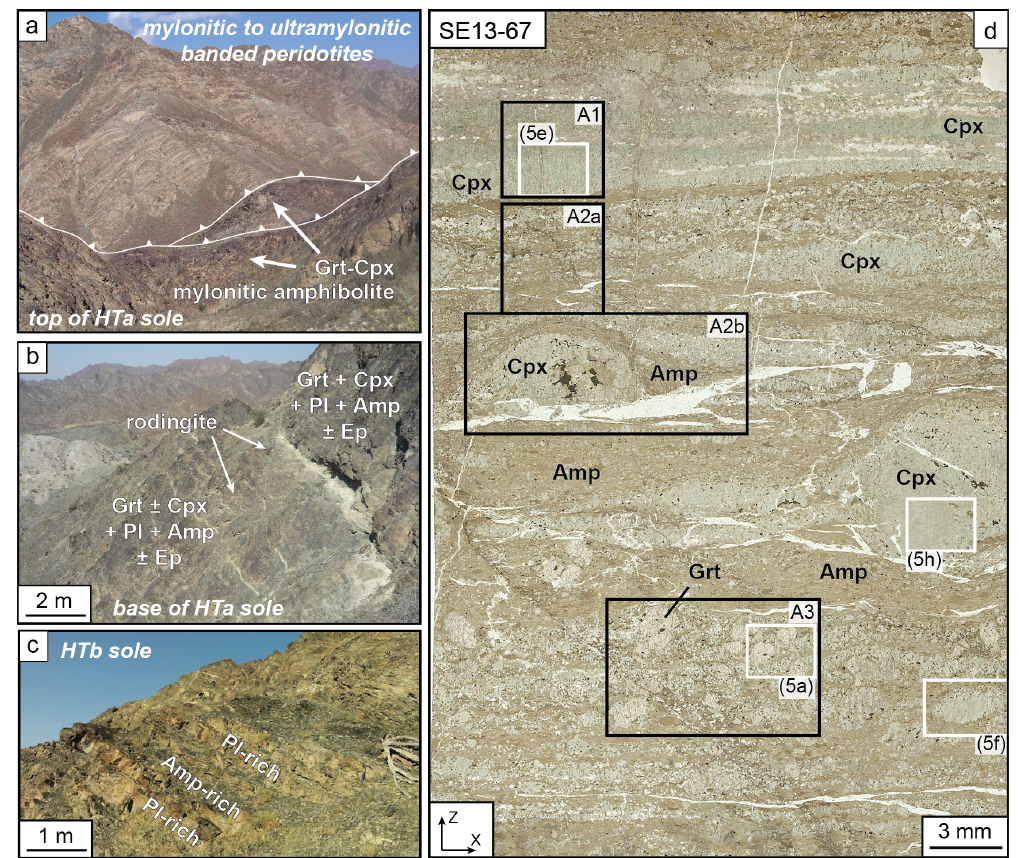
Figure 2. Photographs of the base of the Semail ophiolite outcropping in the Sumeini region (modified after Soret et al., 2017). (a) Basal contact between banded peridotite and the Grt–Cpx amphibolite of the metamorphic sole (zone HTa); (b) base of the HTa unit, widely affected by Ca-rich metasomatism (rodingitization); (c) layered structure in zone HTb with alternations from plagioclase-rich to darker amphibole- rich layers; (d–h) well-preserved mineral equilibrium texture and deformation structure from peak conditions in the HTa amphibolite at Sumeini ( ∼ 2 . 5m from the contact). Black boxes refer to EBSD maps shown in Figs. 3 and 4. White boxes correspond to photographs in Fig.